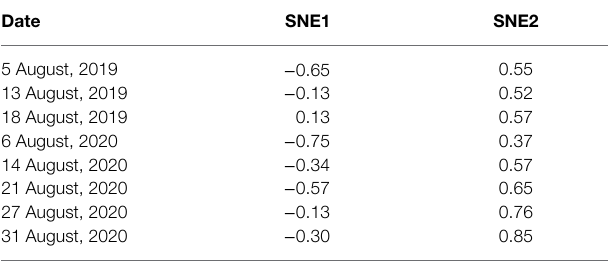
TABLE 1 | Correlation coefficient between t-SNE components and A sat in each measurement